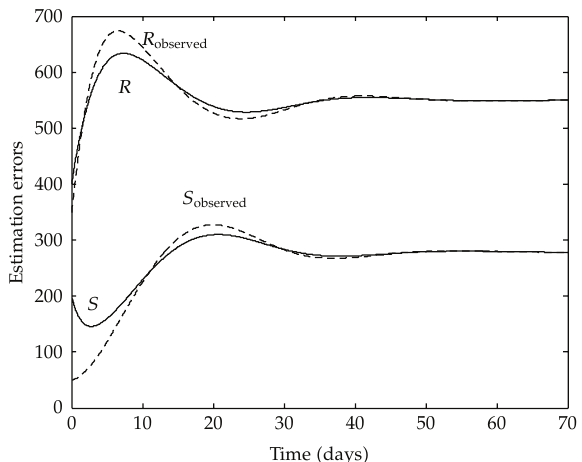
Figure 2: Evolution of the real and observed states for the susceptible and immune.